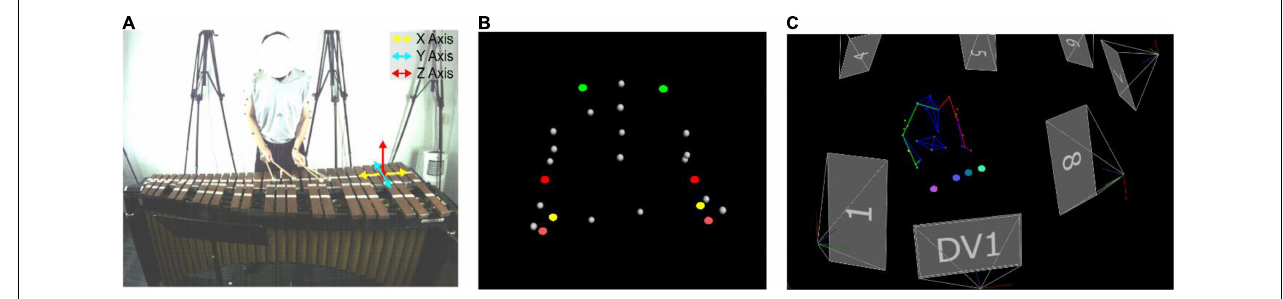
FIGURE 1 | The direction of the movement axes (A) are shown. Marker placements (i.e., green = shoulders, red = elbows, yellow = wrists, and salmon = hands) are shown in panel (B) . Mallet numbers (i.e., seafoam green = LH1, teal = LH2, purple = RH3, pink = RH4) are shown in panel (C)